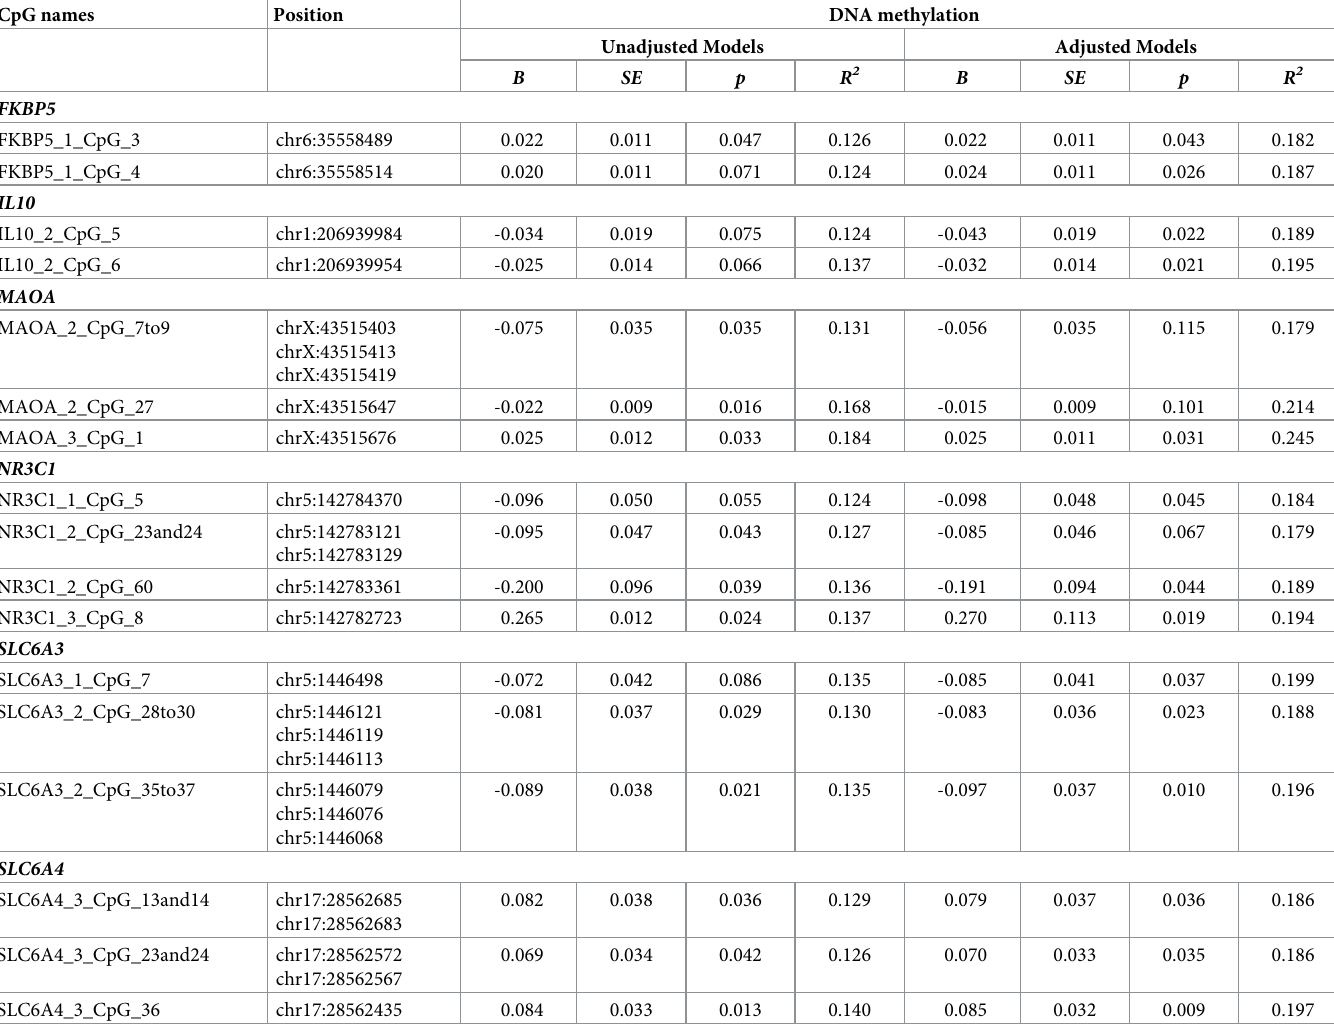
Table 3. Significant interactions between child maltreatment and DNA methylation predicting depressive